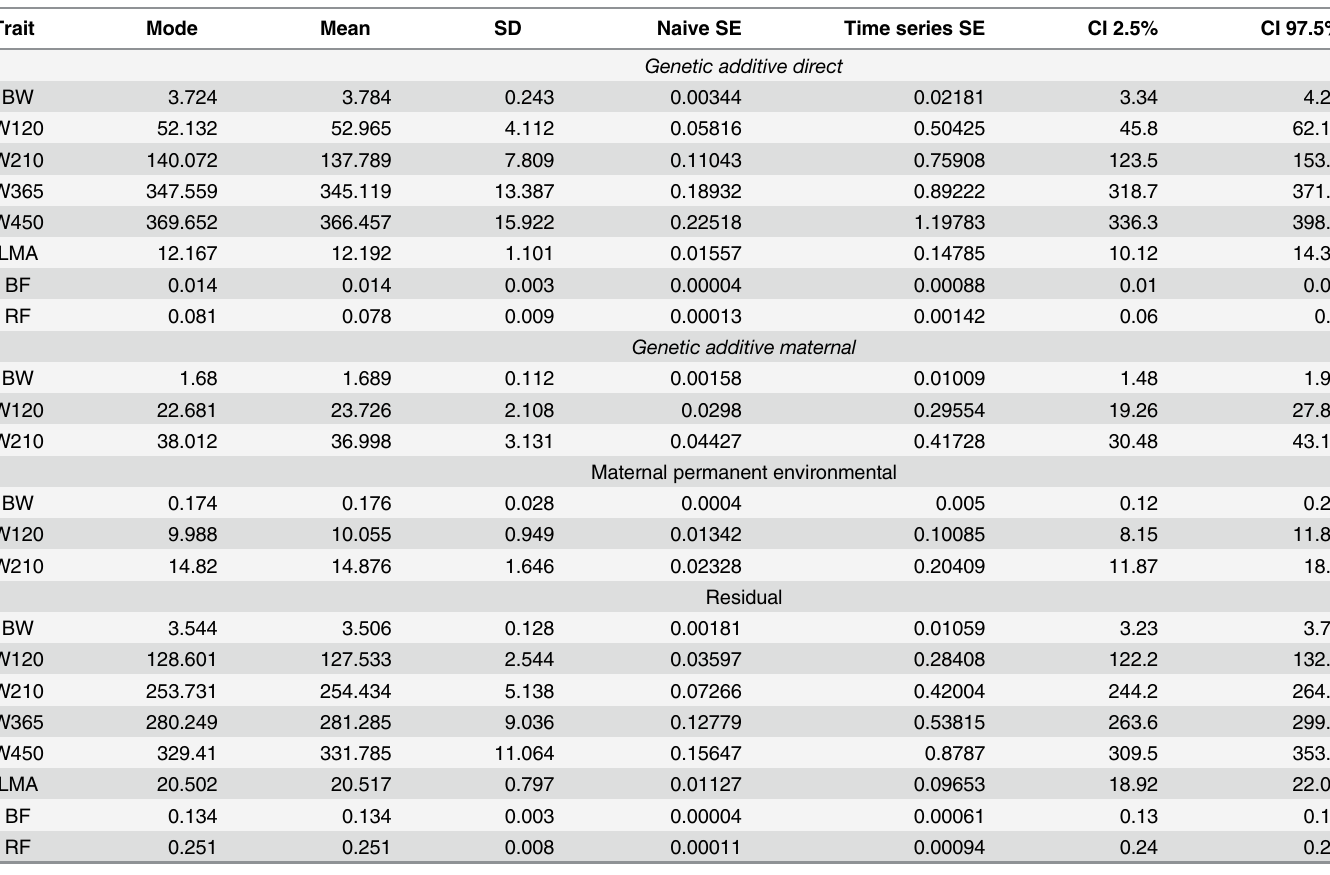
Table 2. Marginal posterior distributions of the genetic direct, maternal, maternal permanent environmental, and residual variance components for growth and carcass traits in Polled Nellore cattle. Trait